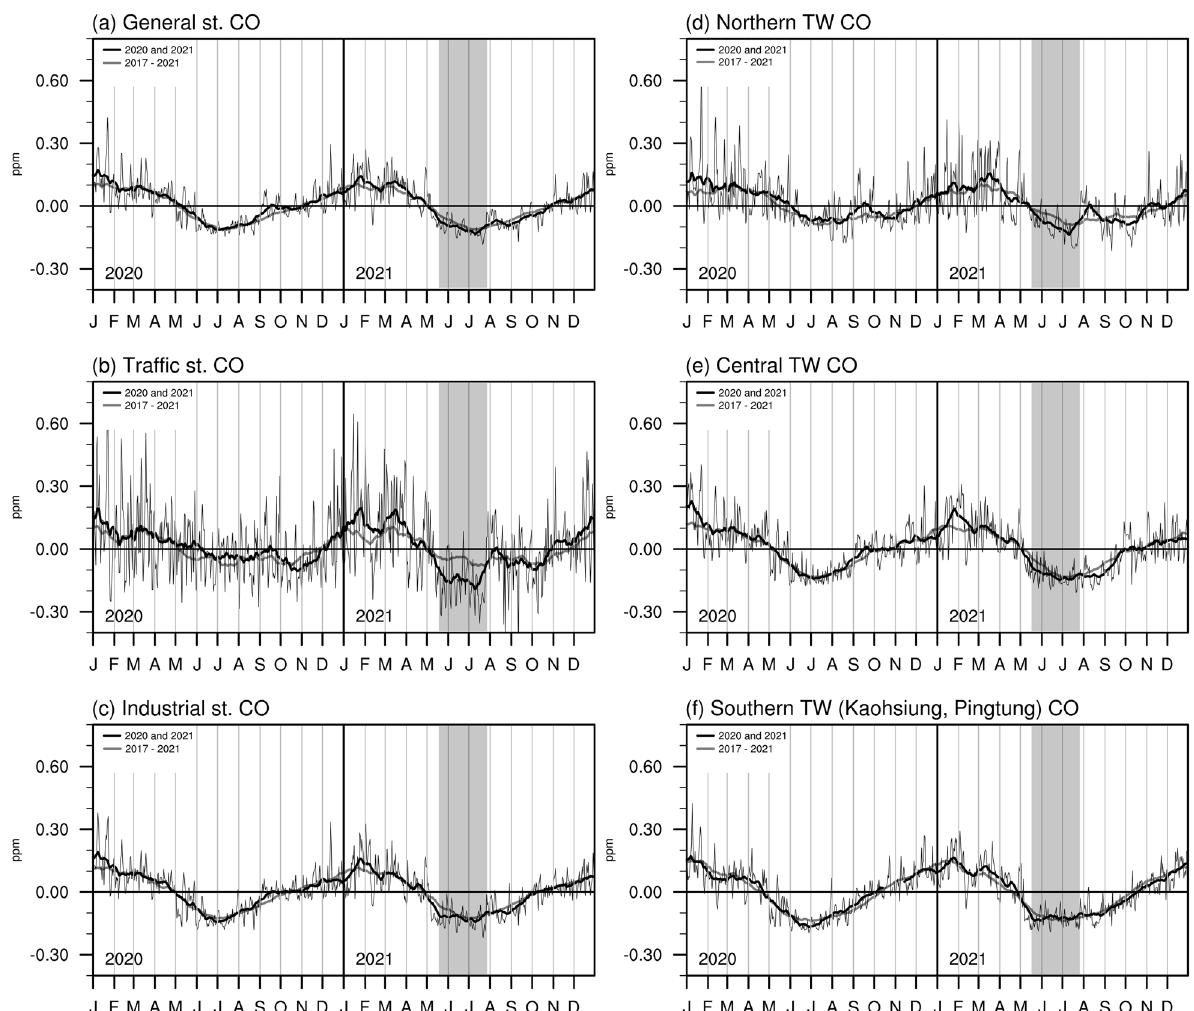
Fig. 7 The annual cycle of CO concentration in 2020–2021 monitored by the ( a) general stations, ( b) traffic stations, ( c) industrial stations, and monitored by the general stations in the ( d) Northern Taiwan region, ( e) Central Taiwan region, ( f) Southern Taiwan region. The daily values are shown in thin black line with 31‑day running mean in bold black line, and the 5‑year mean values (2017–2021) are shown in gray line. Shaded areas denote the period of the Level 3 alert. All the variations have performed detrending operations to remove long‑term change